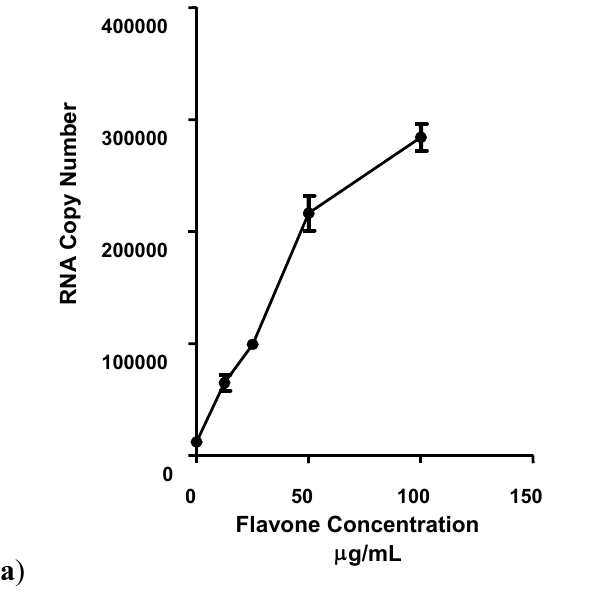
Figure 3. The effects of flavone on intracellular DENV-2 replication in Vero cells. Cells were treated with flavone continuously after virus adsorption and the number of foci formed was determined using the foci forming unit assay ( a ) and the respective DENV-2 RNA copy number was quantified using qRT-PCR ( b ). All experiments were performed in triplicates. Data (n = 3) were plotted using Graph Pad Prism Version